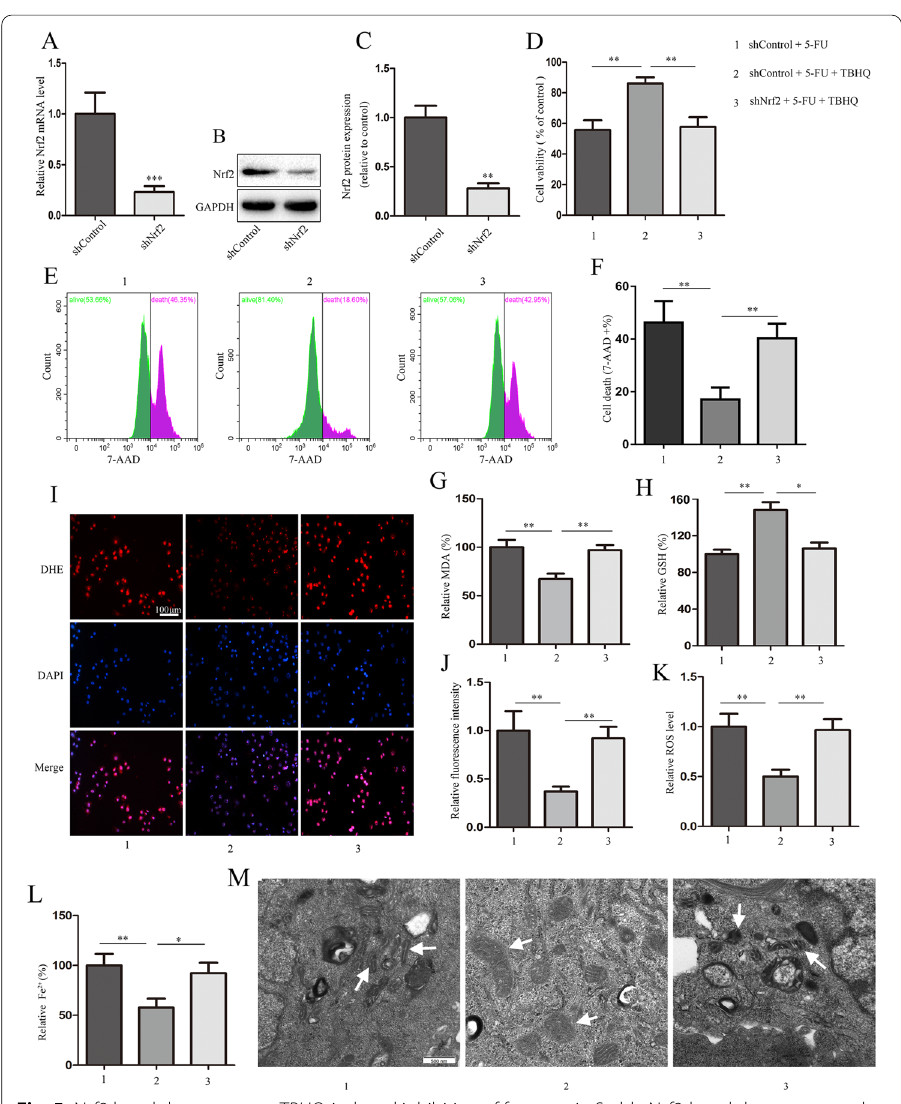
Fig. 5 Nrf2 knockdown reverses TBHQ-induced inhibition of ferroptosis. Stable Nrf2-knockdown or control HIECs were treated with TBHQ (10 μM) in the presence of 5-fluorouracil (5-FU; 5 μM) for 48 h. A through C The expression of Nrf2 determined using quantitative real-time PCR and western blotting assays. D through F Measurement of cell viability and cell death. G , H The relative levels of malondialdehyde (MDA) and glutathione (GSH). I through K The levels of reactive oxygen species (ROS) in HIECs was assessed using DHE staining and flow cytometry, and the quantitative results are shown (scale bars: 100 μm). L The relative levels of Fe 2 + . M Transmission electron microscope images of representative mitochondrial structures (indicated by arrows) in HIECs (scale bar, 500 nm). *p < 0.05, **p < 0.01, ***p <